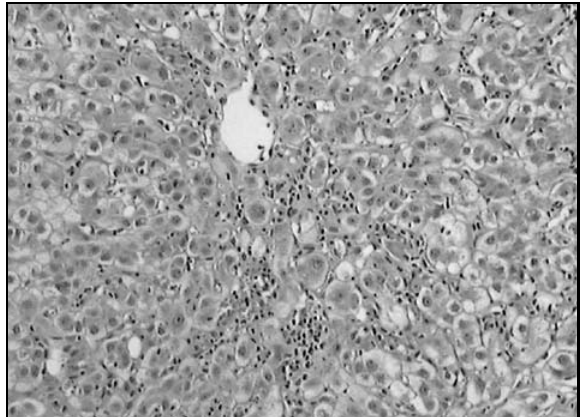
Figura 6 – Zona central do ácino mostrando leucócitos mononucleares enfileirados na região peri-sinusoidal e sinusoidal (H & E, 200X)